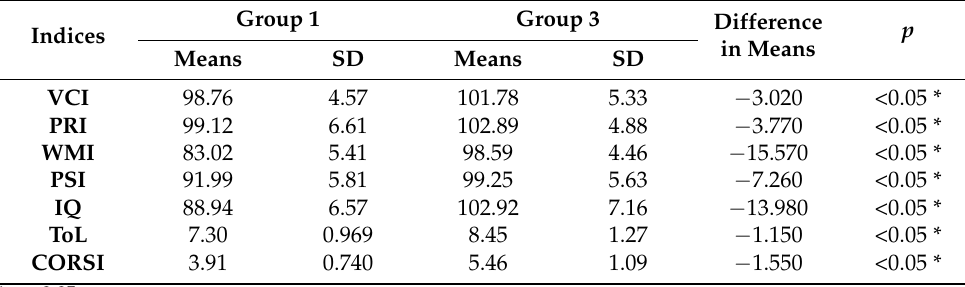
Table 3. Post hoc comparisons between group 1 and 3.